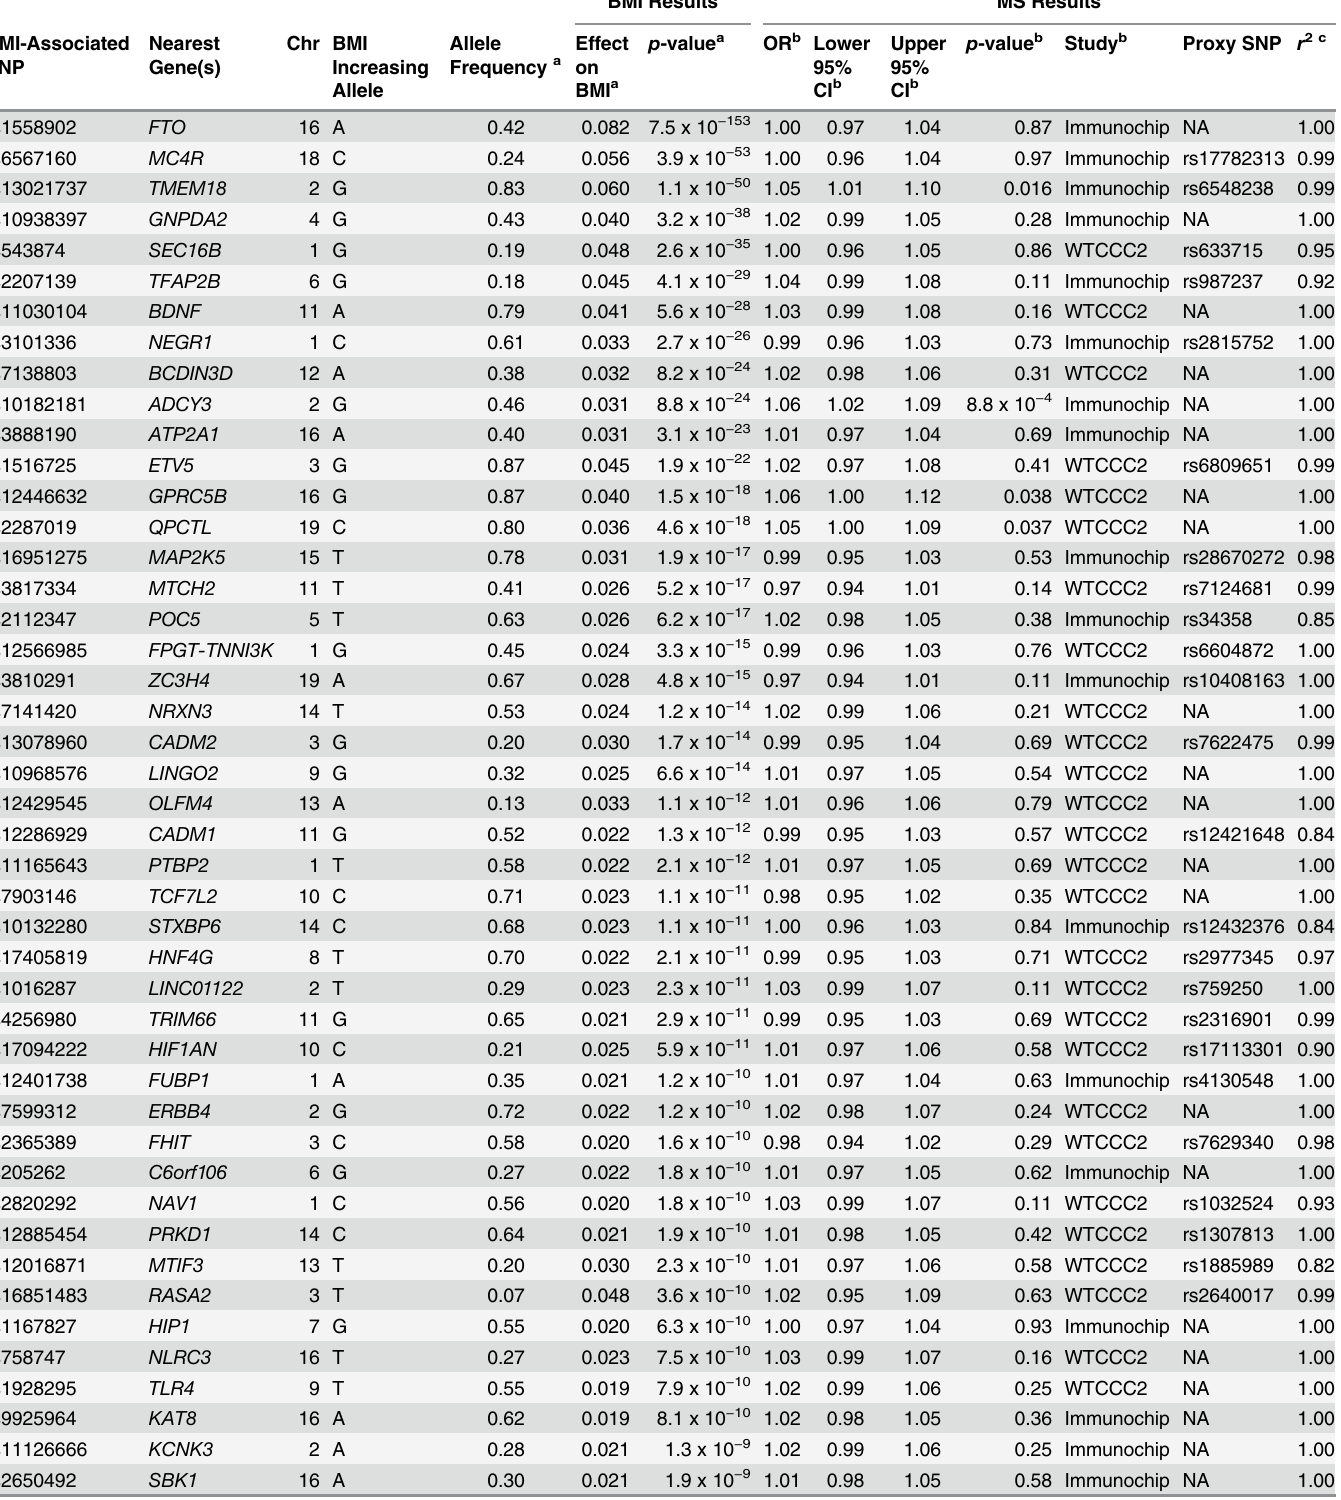
Table 1. Characteristics of SNPs used in MR